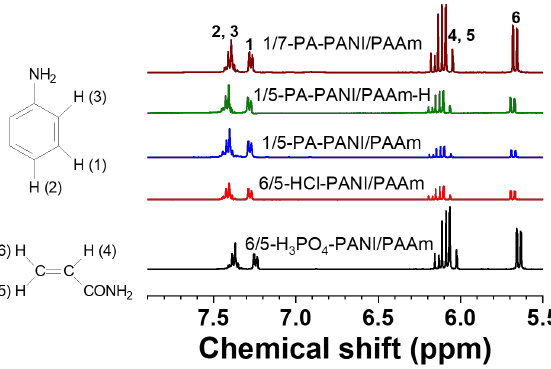
Figure 1. 1 H NMR spectra of the extracts from the five gels with D 2 O. Table 2. Monomer conversions of AAm determined by GS and ANI by HPLC.